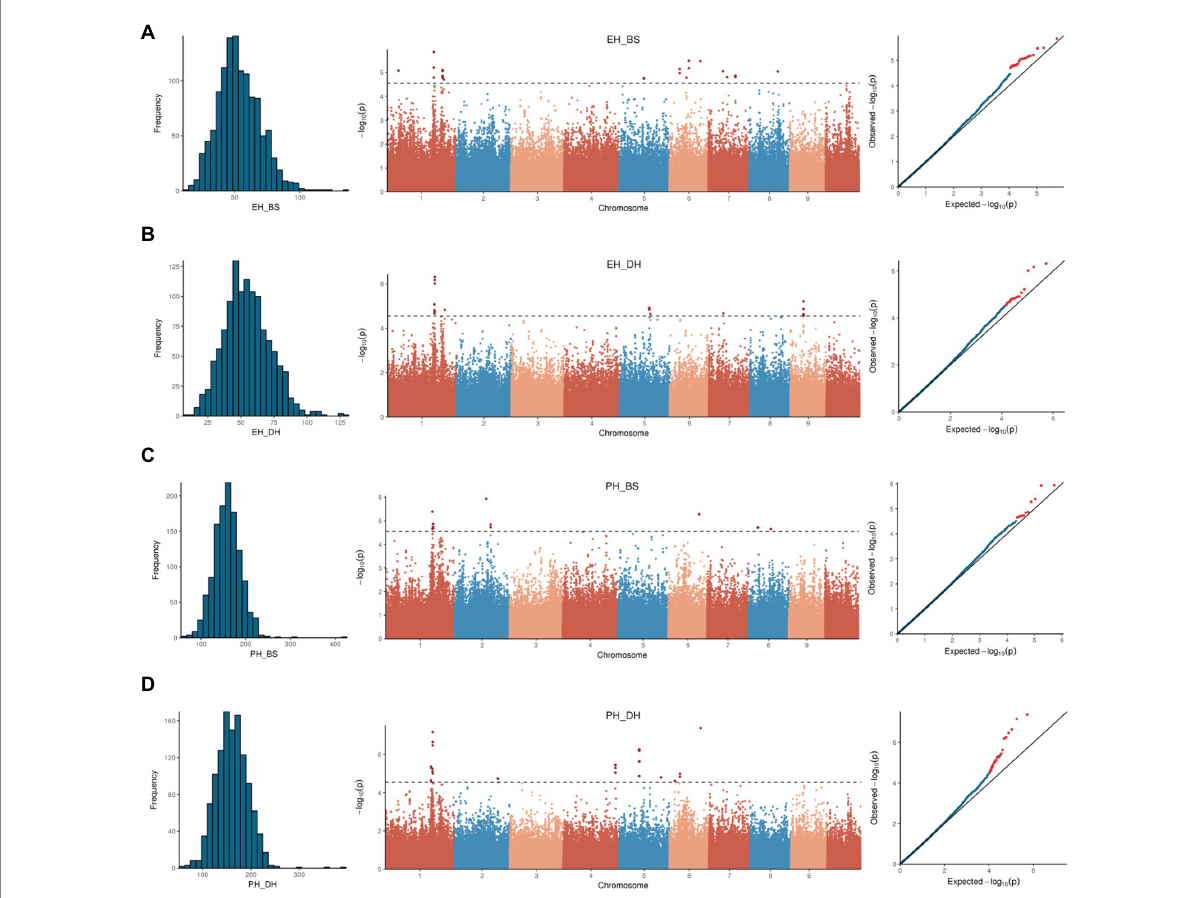
FIGURE 5 Phenotypic distribution, Manhattan and QQ-plot of genome-wide association study for ear height in Baoshan (A) , ear height in Dehong (B) , plant height in Baoshan (C), and plant height in Dehong (D)